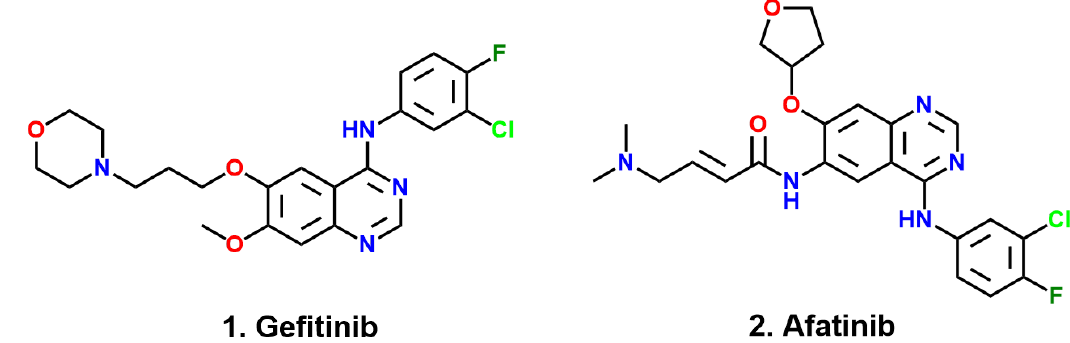
Figure 2. The molecule structure of Gefitinib ( 1 ) and Afatinib ( 2 ).